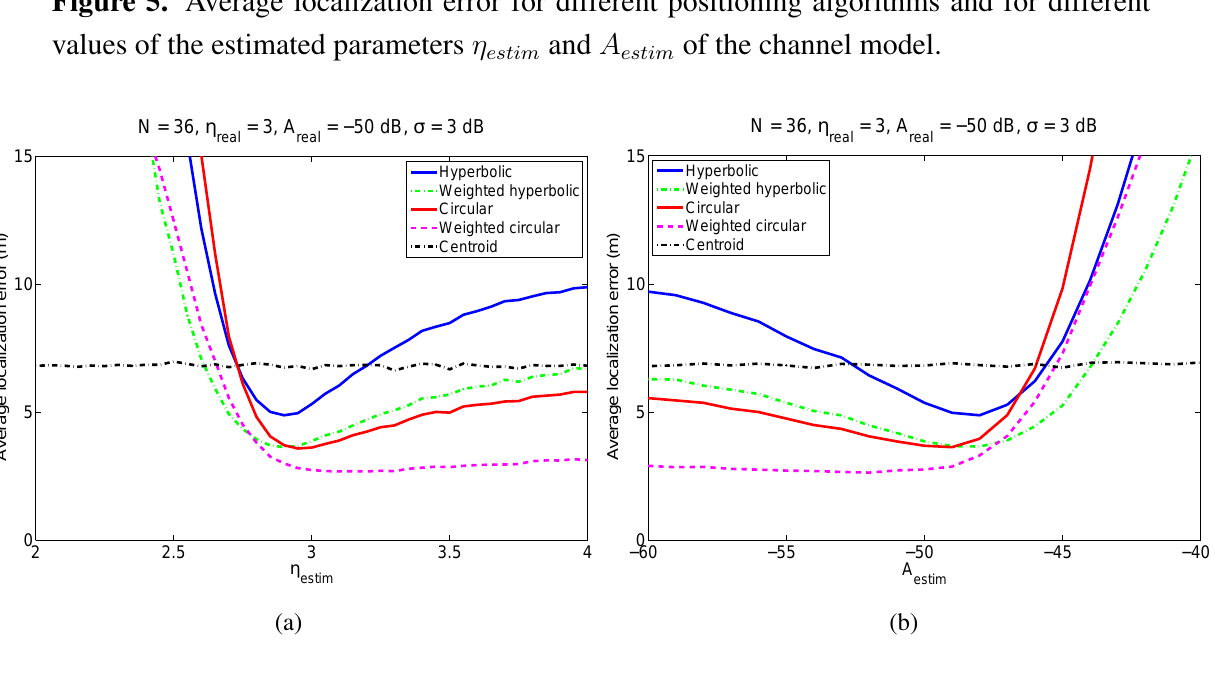
Figure 5. Average localization error for different positioning algorithms and for different values of the estimated parameters η